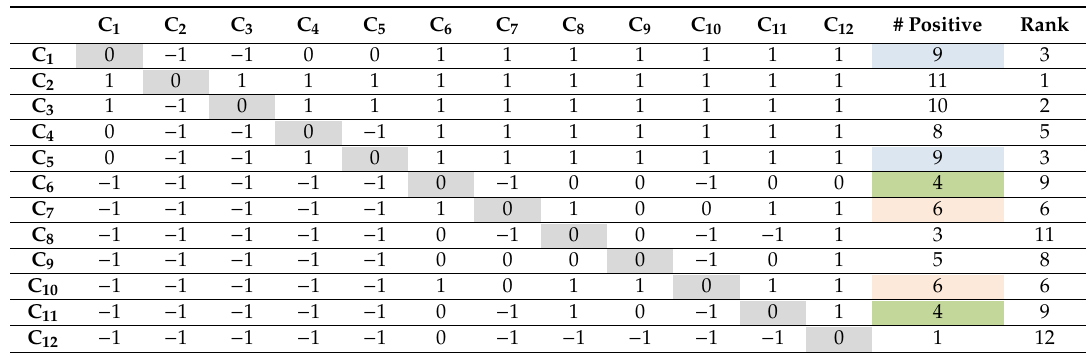
Table 19. Pairwise comparison results (REGIME